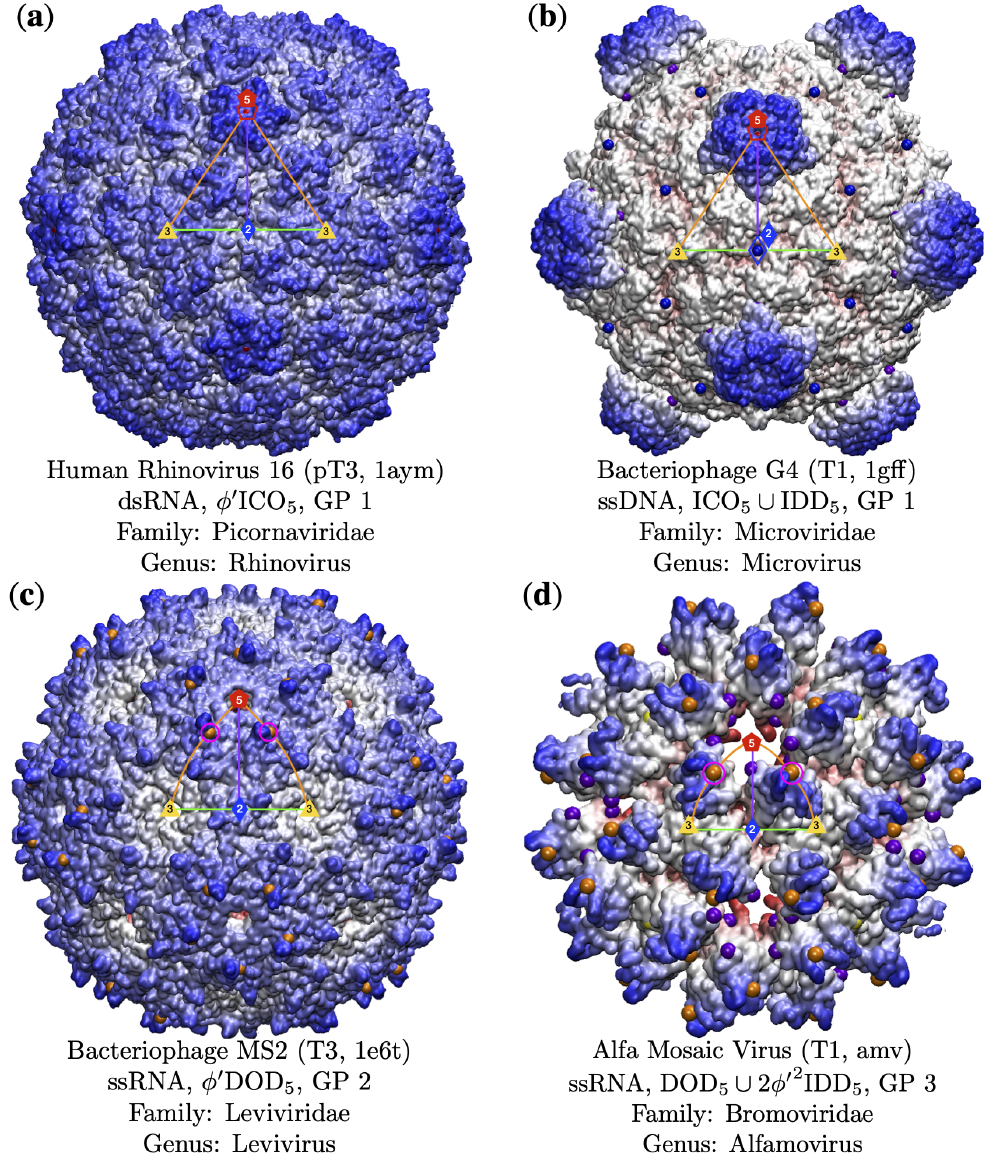
Figure 7. Examples of capsids with gauge points (GP) 1 to 3. The gauge points which correspond to the key structural protrusions are shown in pink circles. The Triangulation number, pdb id, genome composition, point array classification [3]. ( a ) Human Rhinovirus [36] has a structural protrusion on the 5-fold axes (GP 1). There is another protrusion along the 5–3 GC; however, none of the point arrays corresponding to these protrusions fit the virus capsid well [3]. ( b ) Bacteriophage G4 [37] uses GP 1 for its protrusions. GP 21 was also a possible fit; however, none of the point arrays associated with this gauge point were a good fit for the capsid. ( c ) Bacteriophage MS2 [38] has surface loops at GP 2, as shown. Previous experimental work showed that while these loops do not appear structural in nature, changes to the amino acids adjacent to GP 2 was nearly impossible [3,20,21]. As all of the proteins in MS2 are chemically identical, this restriction to modification extends to all protrusions of MS2 pre-assembly. ( d ) Alfa Mosaic Virus [39] uses GP 3 for its protrusions and has remarkable agreement (6 radial levels, [3] with the double point array DOD 5 ∪ 2 φ (cid:48) IDD 5 and with an RMSD of 1.6